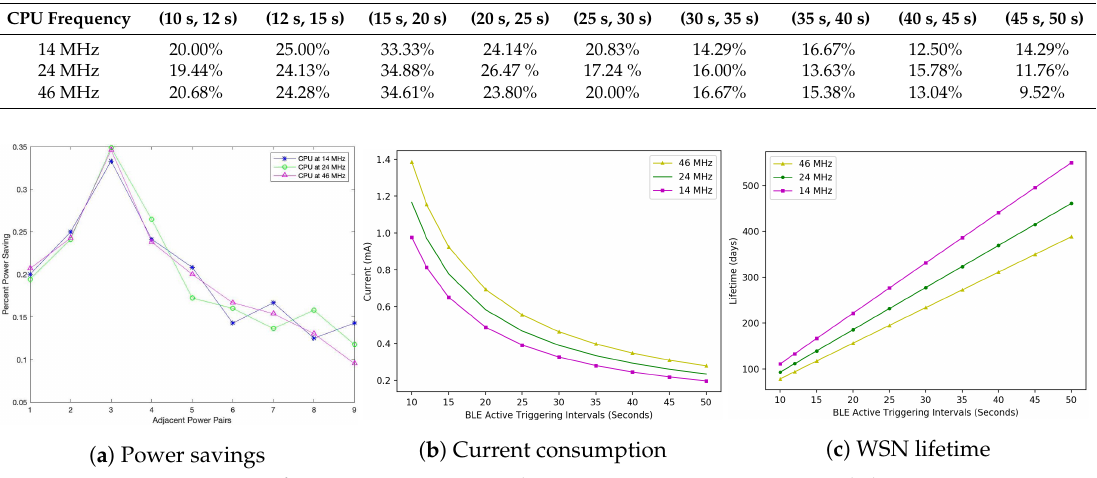
Table 8. Percentage of power saved between adjacent active triggering intervals.